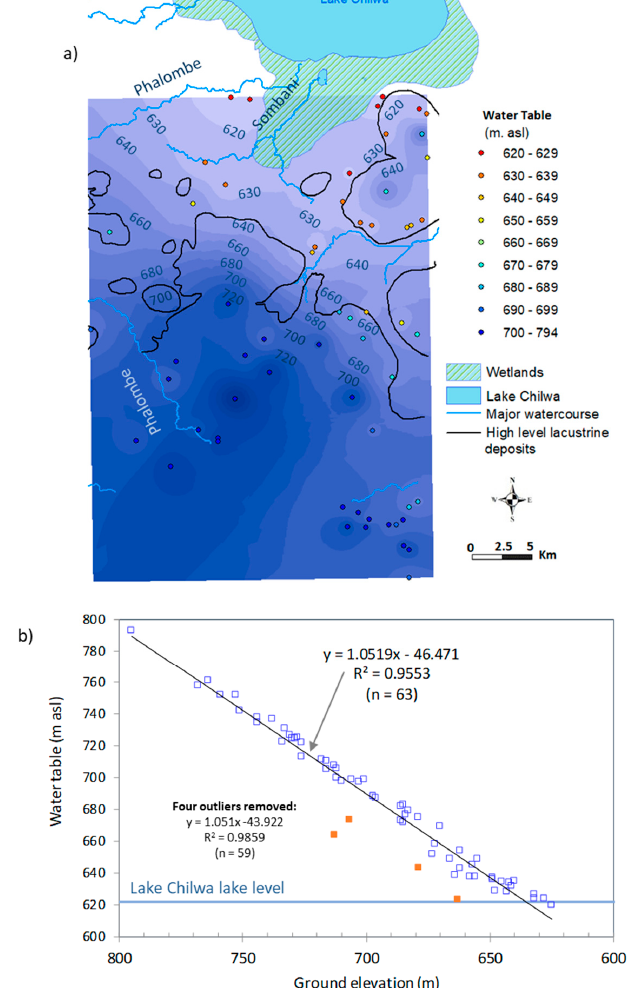
Figure 5. ( a ) Contoured potentiometric surface (water table) at 10 m intervals for the Phalombe District based on water level data mostly from 2017; ( b ) plot of water table versus ground elevation. The four outliers are excluded from the spatial data, but included in Figure S6, where the most marked outlier causes a central western margin flow-field sink